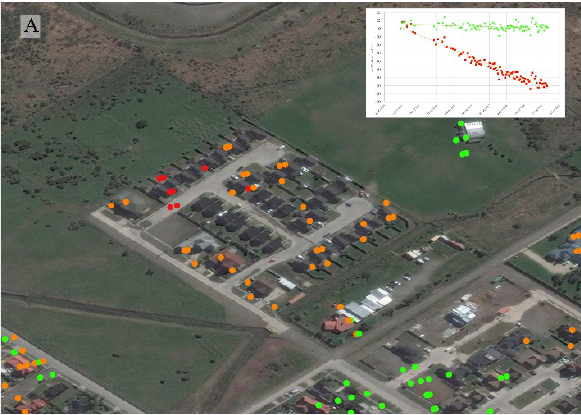
Figure 3. Example of displacement area and time series.